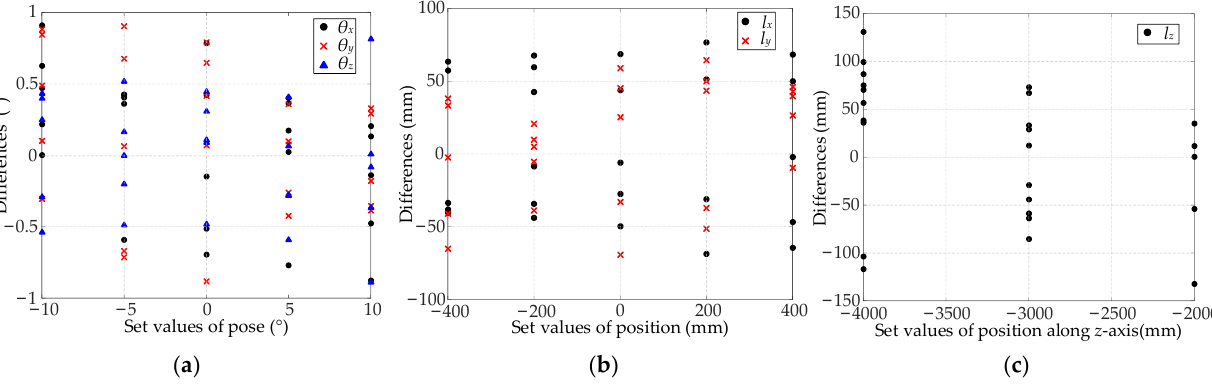
Figure 18. PPARD estimation results: ( a ) θ x ; ( b ) θ y ; ( c ) θ z ; ( d ) l x ; ( e ) l y ; ( f ) l z .